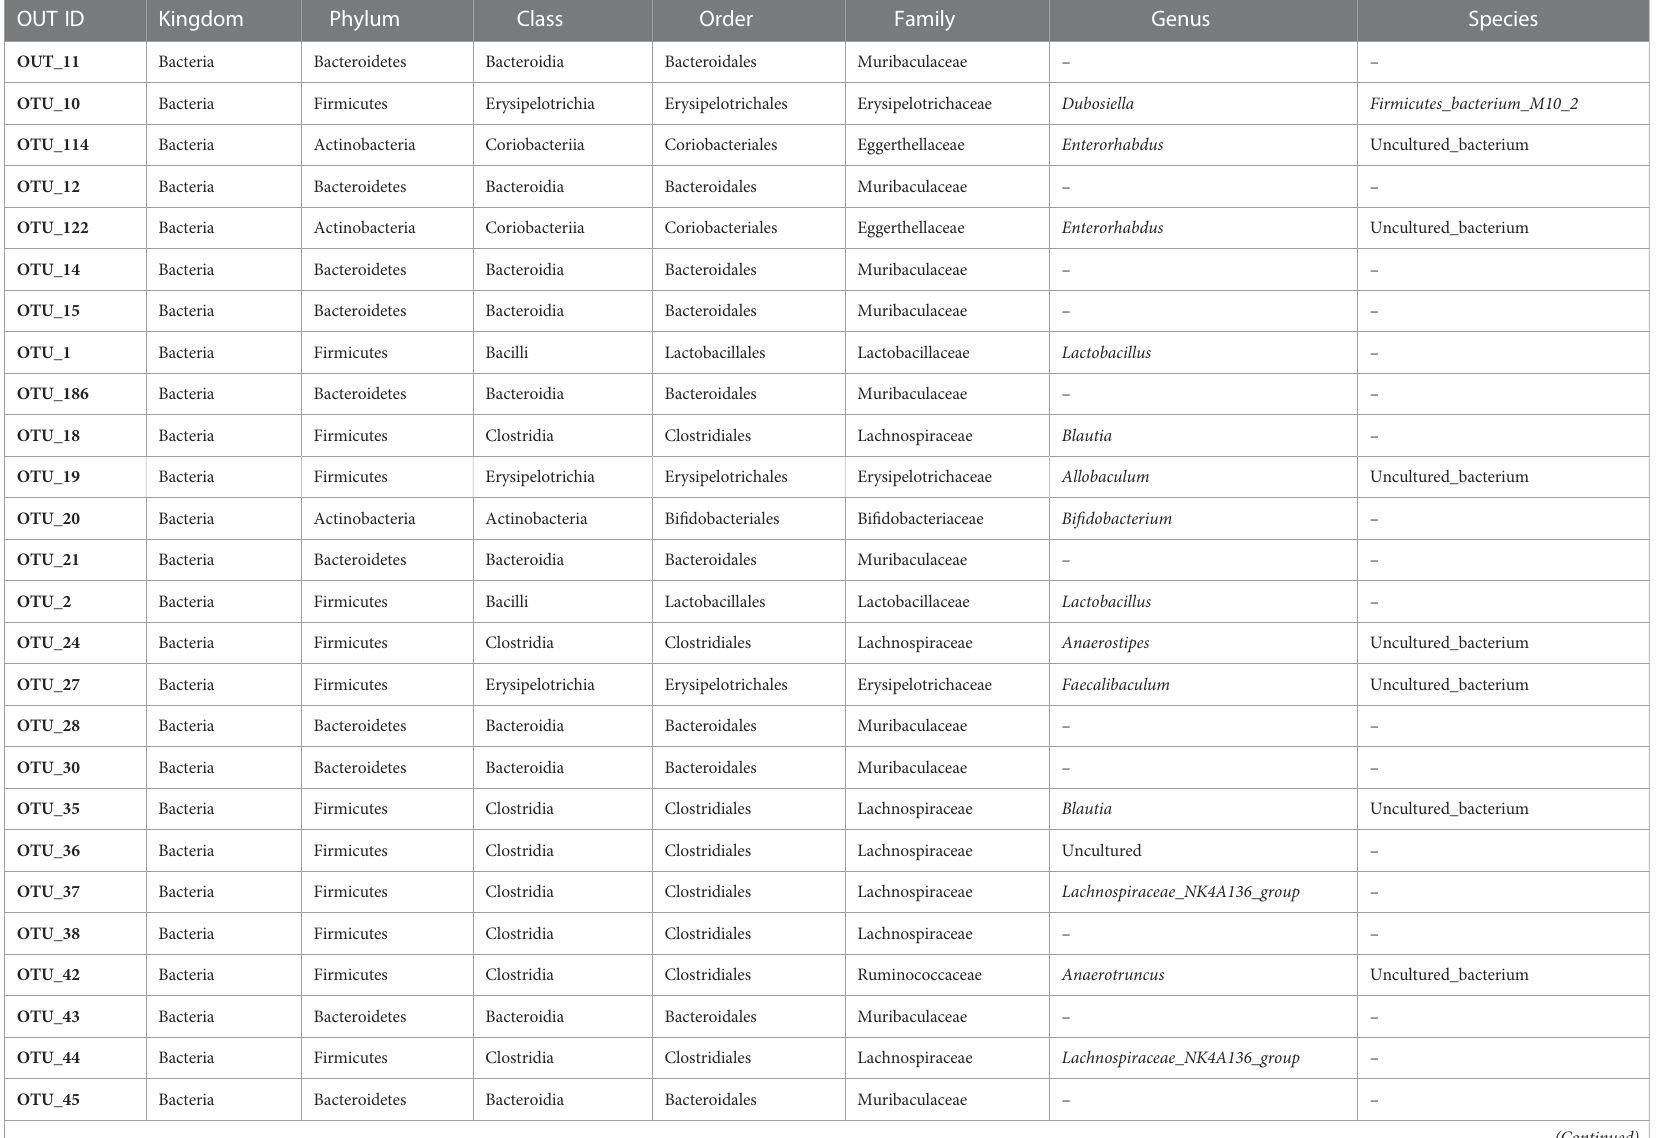
TABLE 1 The 35 common gut microbiota in different segments of the intestine. OUT